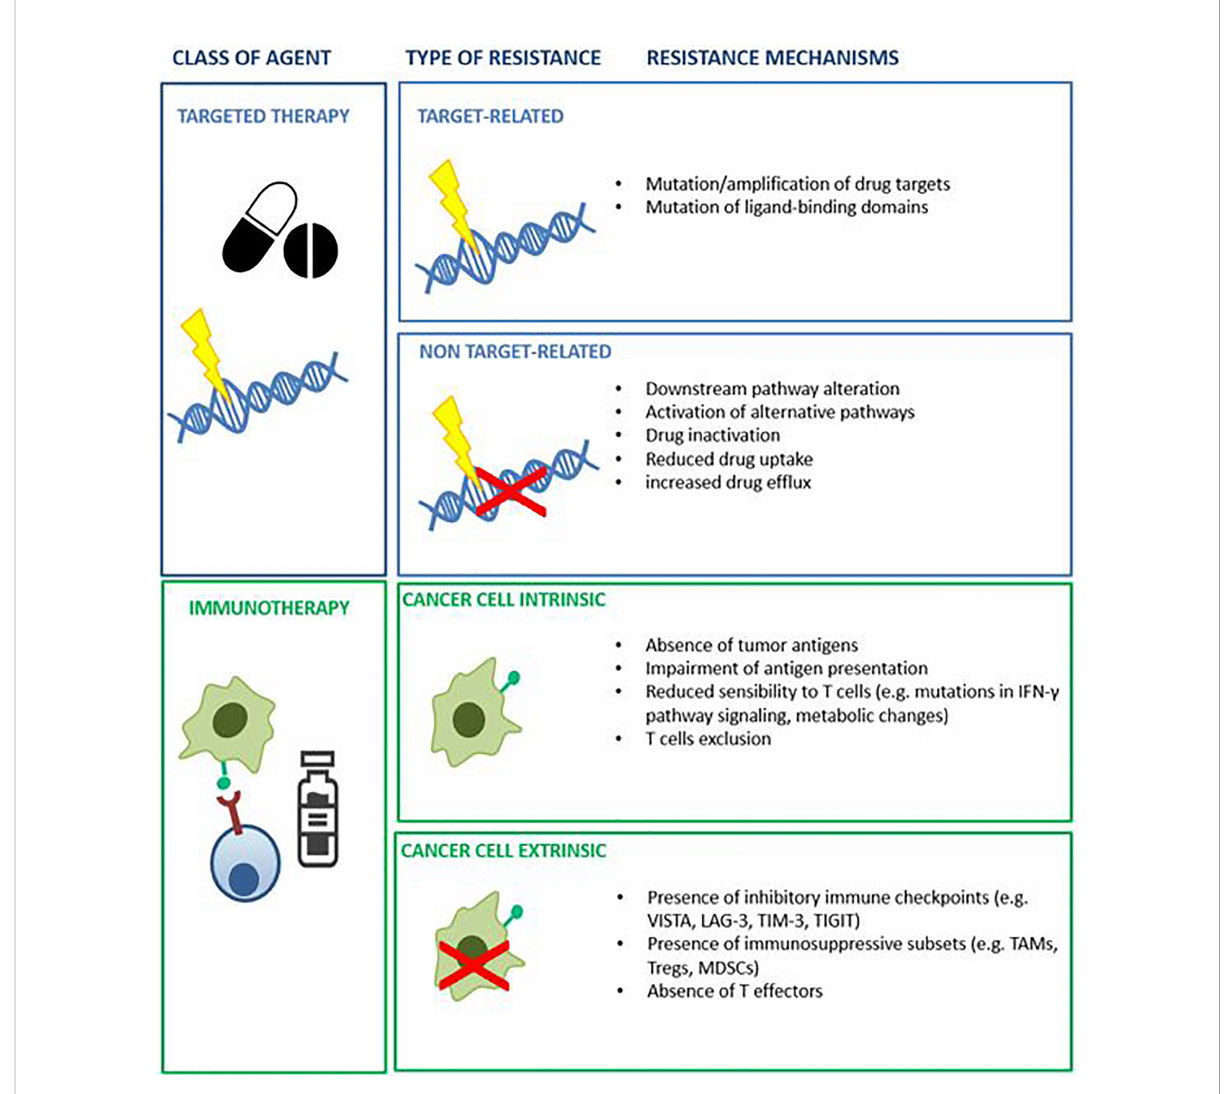
FIGURE 1 Example of known mechanism of resistance to targeted agents and